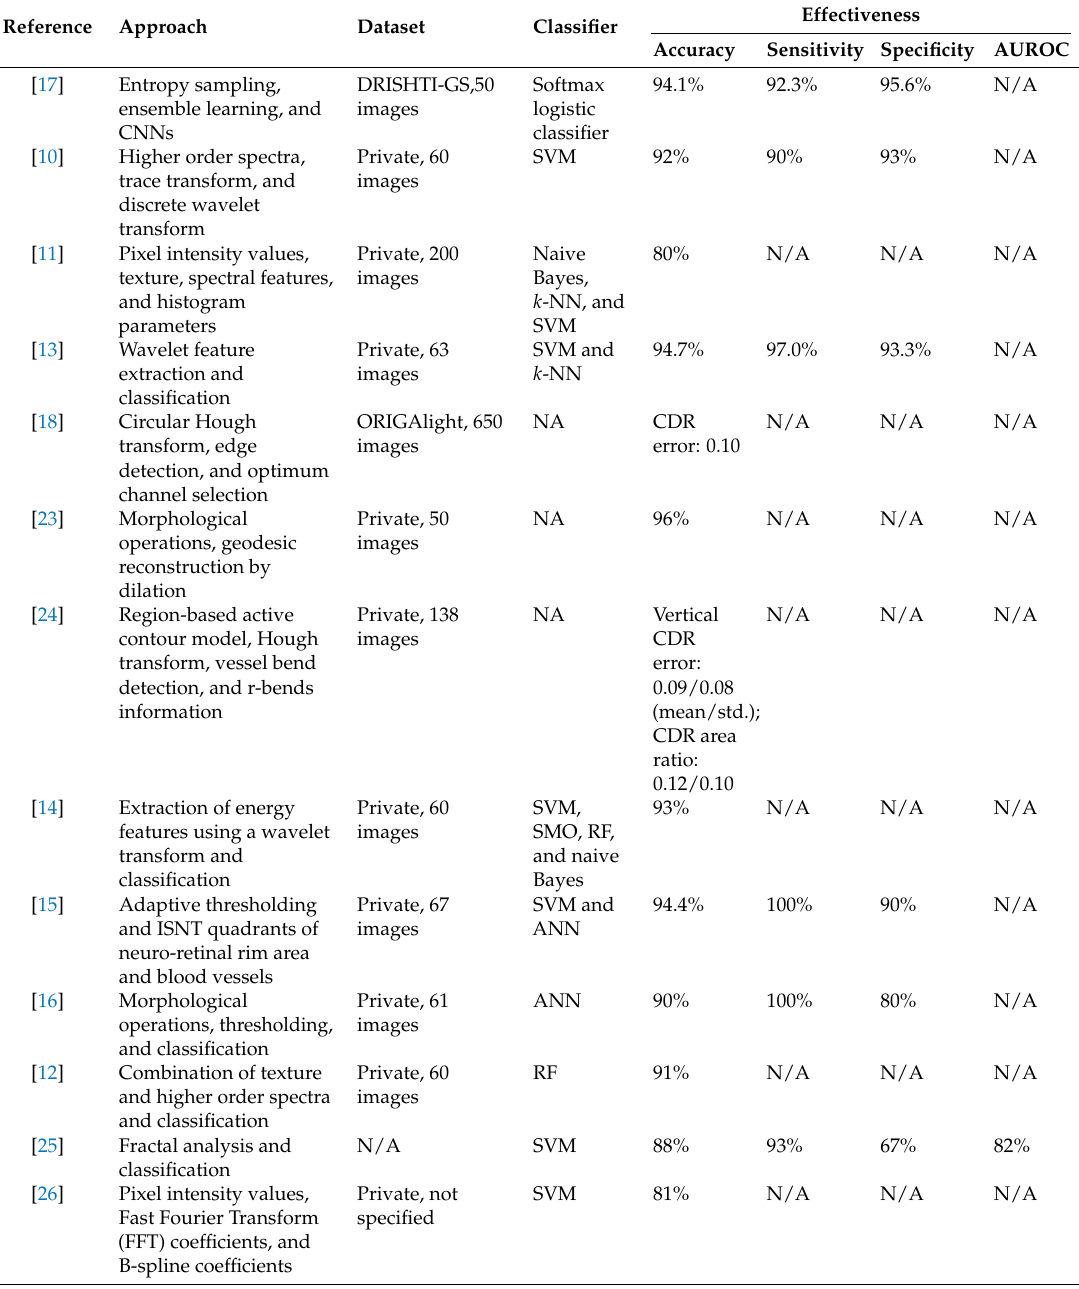
Table 1. Overview of computer-aided diagnosis for glaucoma. The dataset described covers both training and validation sets. Effectiveness results have been rounded to one decimal place, if applicable. CDR, Cup-to-Disc Ratio; SMO, Sequential Minimal Optimization; ISNT, Inferior, Superior, Nasal,